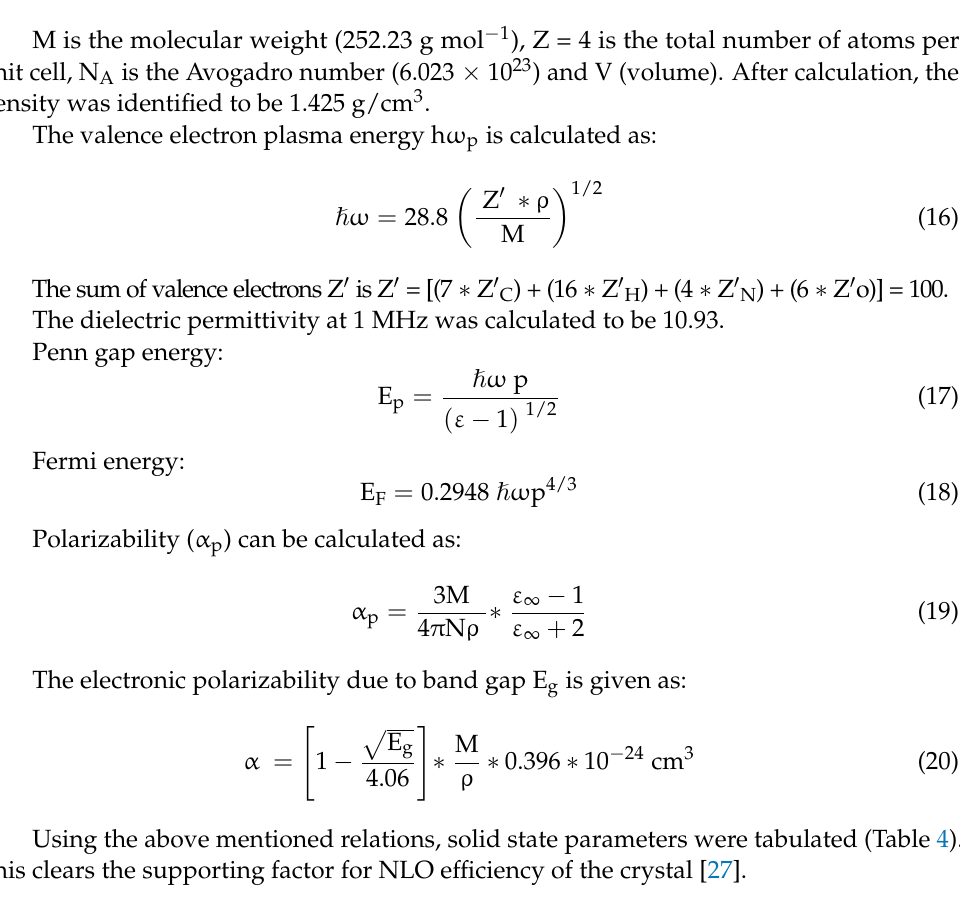
Table 4. Calculated parameters of UGA. Solid State Parameters